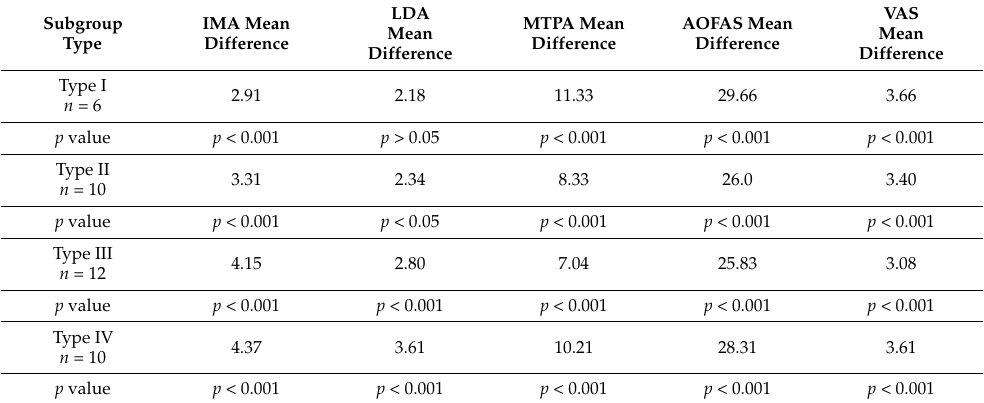
Table 4. Subgroup results of the pre- and postoperative radiographic measurement and clinical